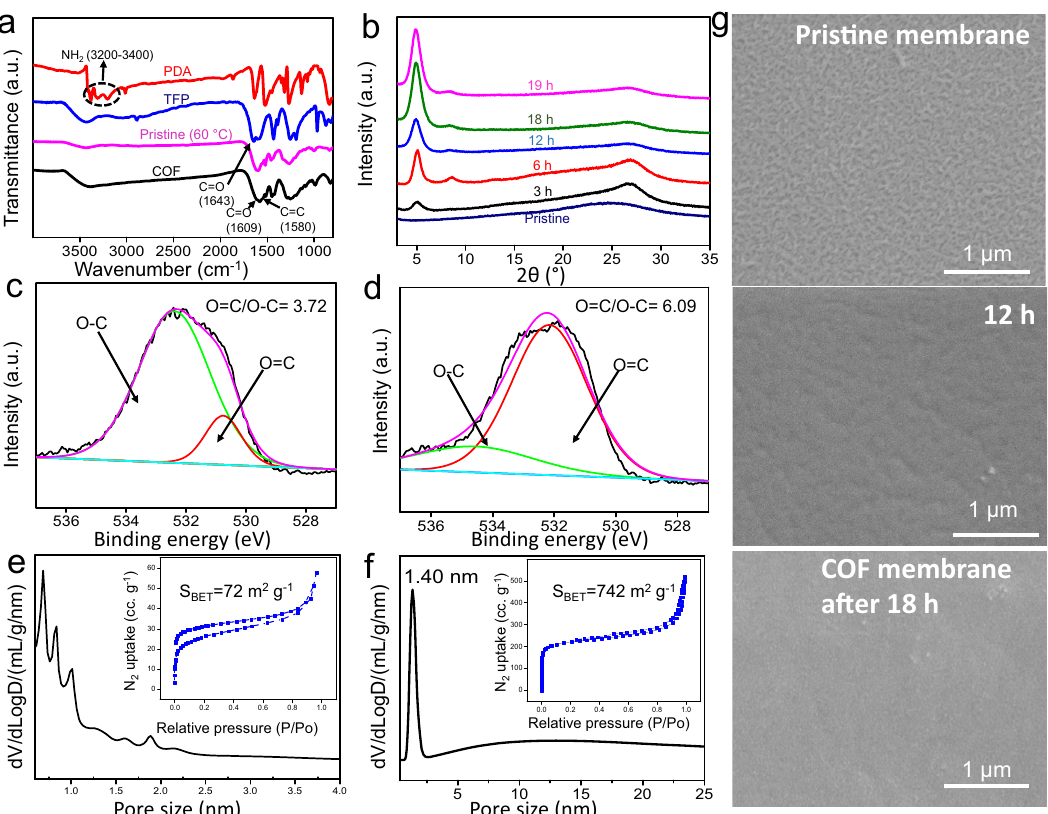
Fig. 4 Pristine to COF transformation (TFP-PDA). a FT-IR of monomers, pristine and COF membrane. b Time-dependent XRD. c , d XPS of pristine and COF membranes. e , f BET of pristine and COF membranes. g SEM showing membrane surface change from pristine to COF membranes.